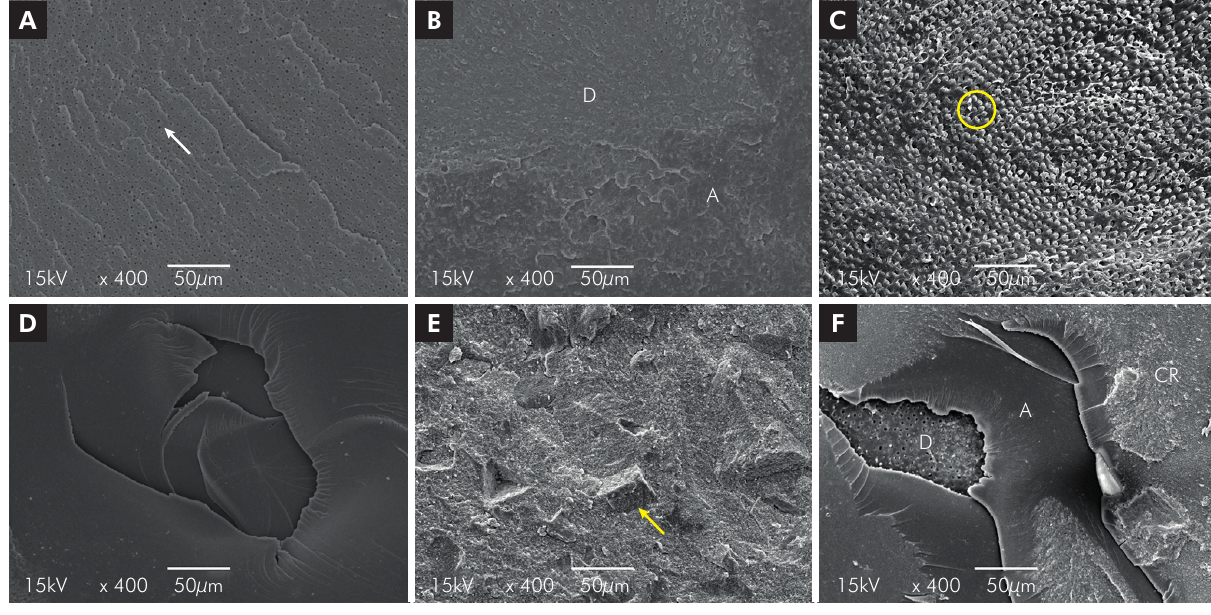
Figure 3. SEM micrographs of representative fracture patterns. (a) Type I (HER/OBF – 1y storage). Cracks within the dentin substrate, and small open dentinal tubules can be seen (white arrow); (b) Type II (FBF/SBU – 1y storage). Smear plugs and a thin layer of adhesive are present; (c) Type III (HER/OBF - 24h storage). Circled area shows resin tags remaining in dentinal tubules; (d) Type IVSDR/XPB - 24h storage). Scale-like structures can be seen in the fractured adhesive layer; (e) Type VI (SDR/XPB – 1y storage). Filler particles from the composite can be seen (yellow arrow); (f) Type VII (TEC/TNB – 1y storage).